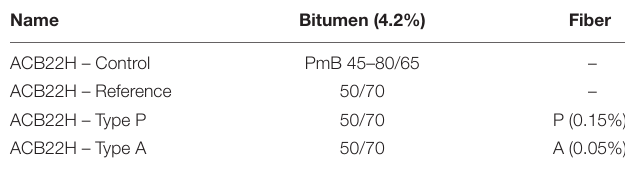
TABLE 1 | Dense asphalt mixtures (AC B 22 H) prepared for the experimental